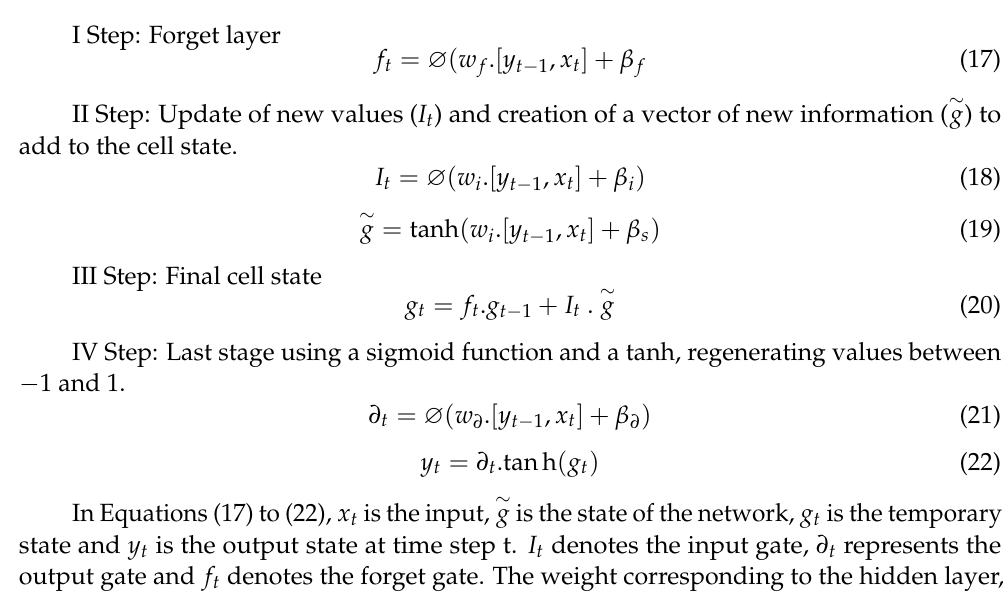
Figure 1. LSTM network and detail structure of an LSTM cell.